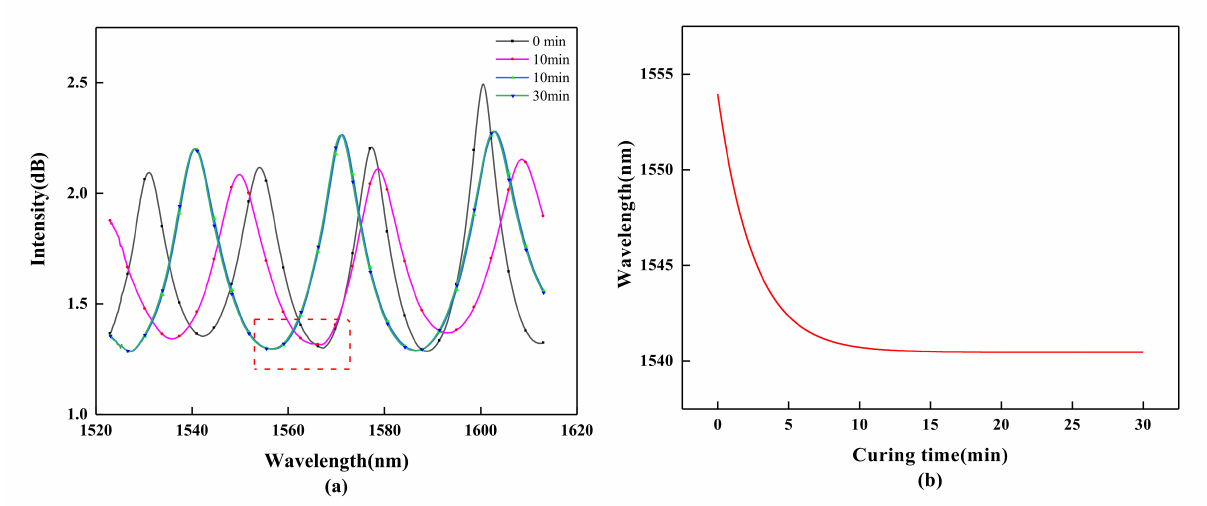
Figure 4. AB adhesive curing time spectrum: ( a ) Reflected spectrum at different curing times; ( b ) Fitting image of curing